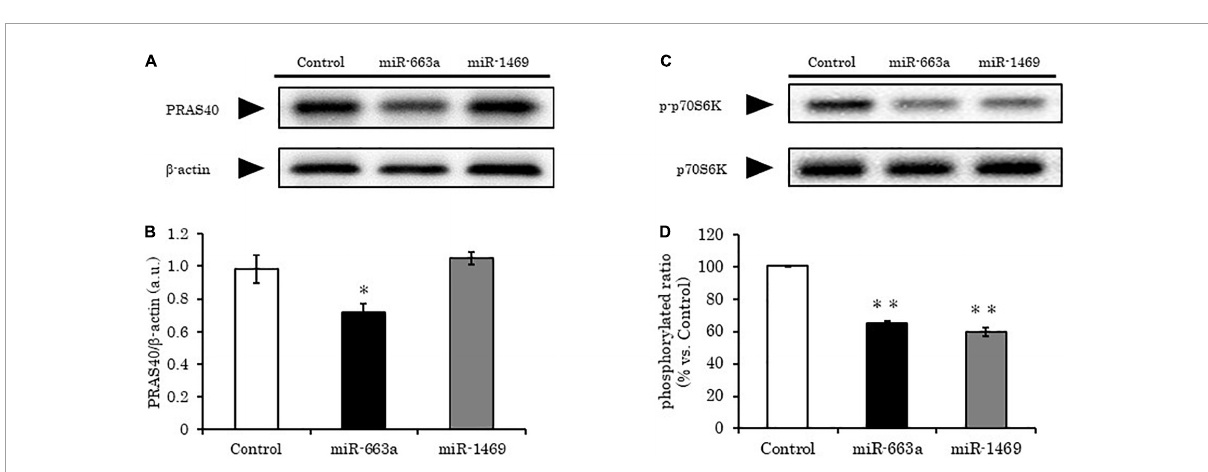
FIGURE3 hsa-miR-663a targeting PRAS40 and hsa-miR-1469 decrease phosphorylated p70S6K levels in HepG2 cells. HepG2 cells were transfected with 80 nM hsa-miR-663a and hsa-miR-1469 mimics for 48 h and analyzed using western blotting. (A) Representative western blot bands for PRAS40. (B) Quantification of panel (A) . (C) Representative western blot bands for p70S6K and phosphorylated p70S6k. (D) Quantification of panel (C) . Data are mean ± SE. * p < 0.05 and ** p < 0.01, vs.